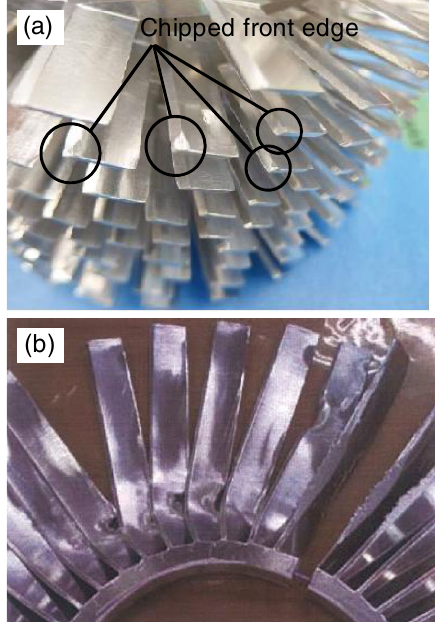
FIG. 9. Damaged rotor and stator blade of the TMP. The diameter of the rotor and stator is about 220 mm. (a) Chipped edges of the rotor. (b) Deformed stator blade.